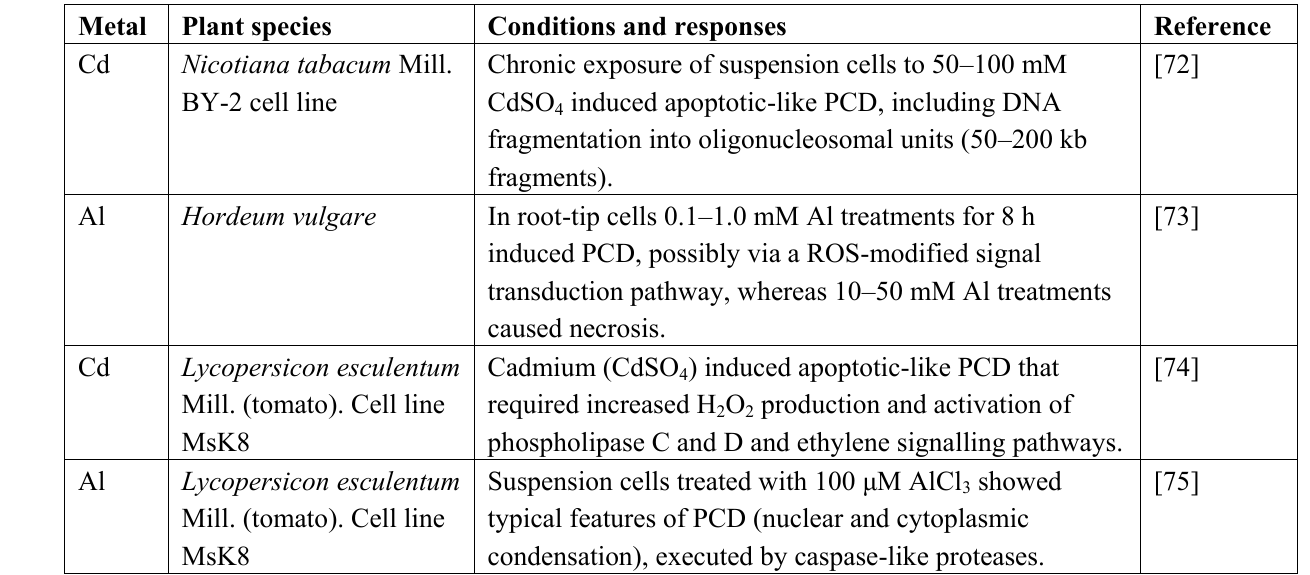
Table 2. Programmed cell death (PCD) induced by toxic metals in